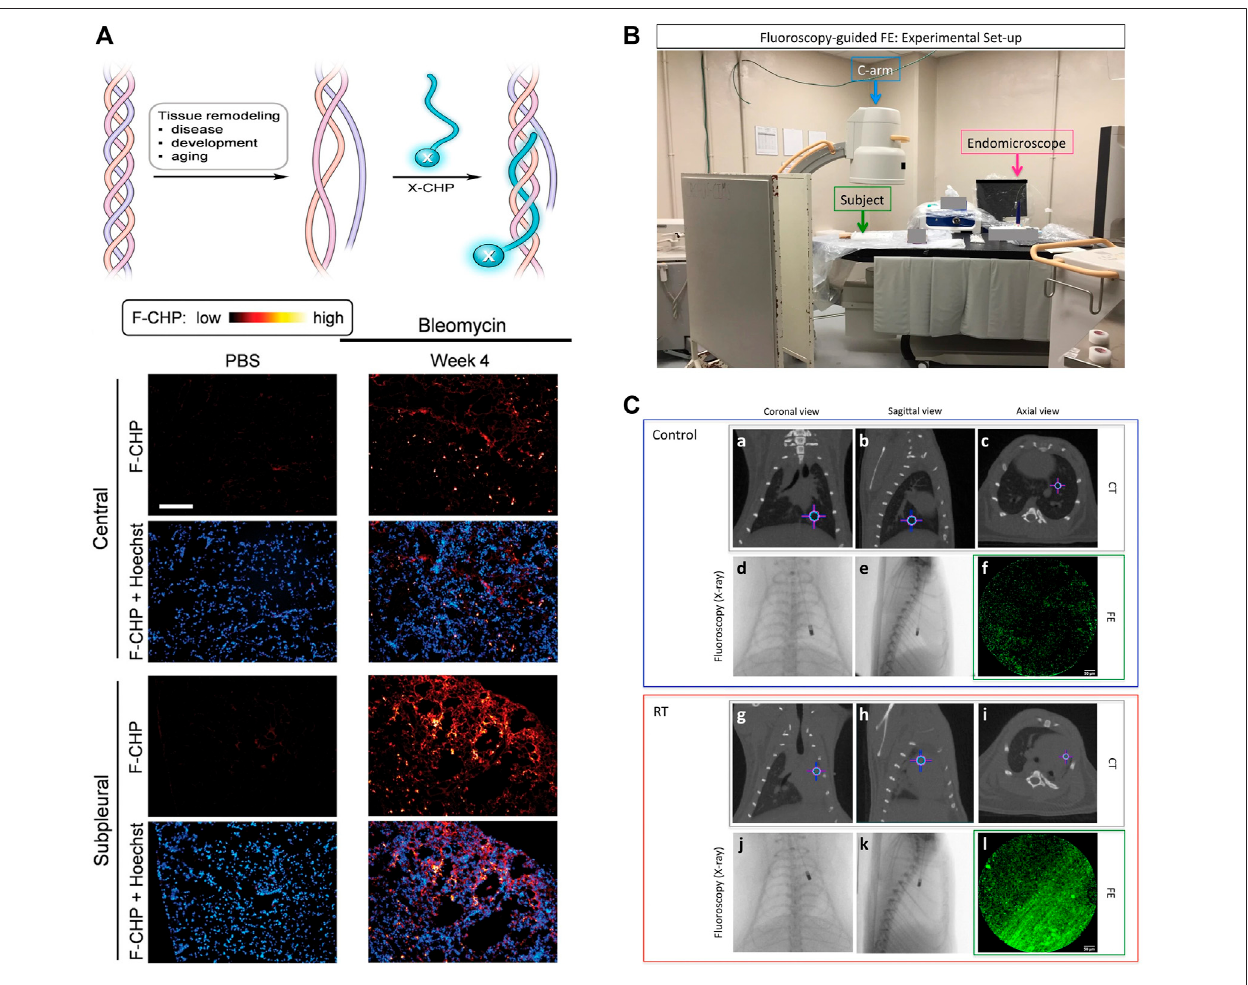
FIGURE 1 | (A) Schematic of a CHP strand (labeled with X) hybridizing to denatured collagen chains and forming a collagen triple helix and representative fl uorescence micrographs of the center and subpleural area of frozen lung sections, which were obtained from bleomycin mice and control mice. (B) Experimental set- up. (C) Representative CT(a-cand g-i,gray box)and FE(f and l,greenbox) images ofcontrol(a-f,blue box)and RT (g-l, red box)at thecorrespondingendomicroscope positiondeterminedwiththe fl uoroscopyimages(d,eandj,k,respectively).Crosshairindicatesthepositionoftheendomicroscopetip.Adaptedandmodi fi